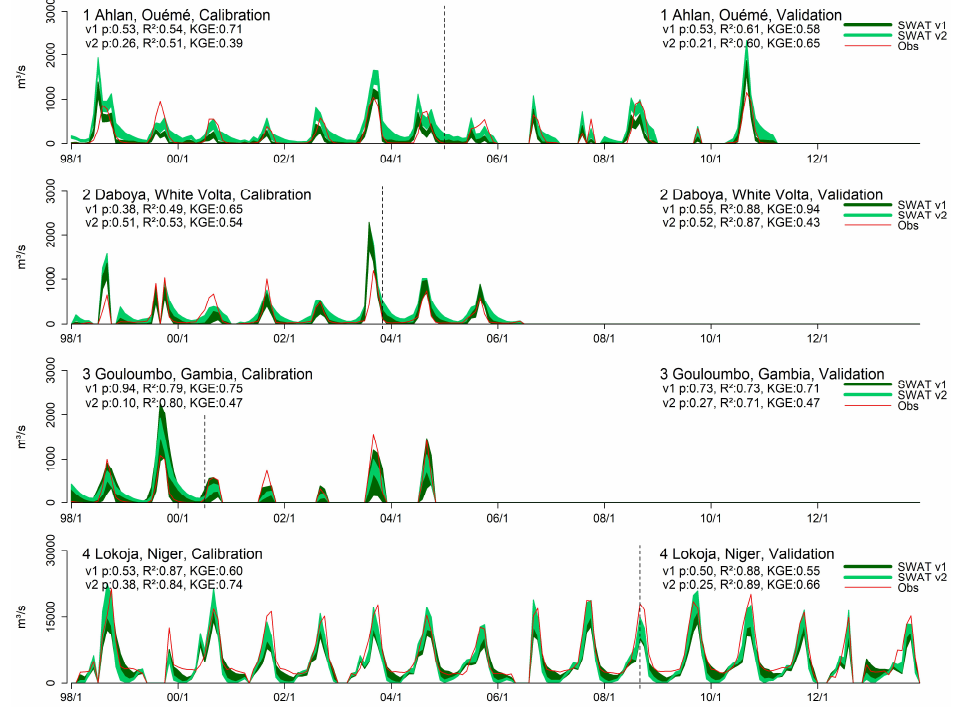
Figure 5. Example Discharge Results for the South (1&2), West (3) and Niger (4) Models.